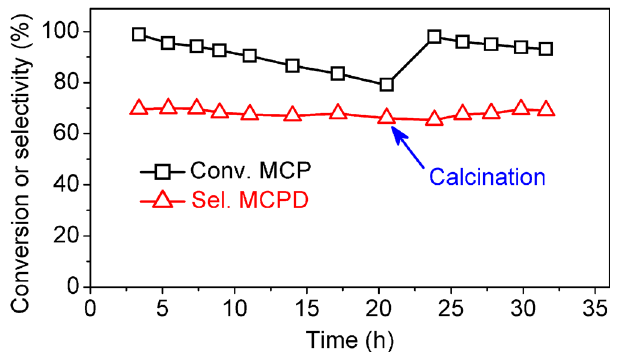
Fig. 4 The catalytic stability of 15wt.%MoO 3 /ZnO catalyst. Conditions: T = 400 °C, PH = 0.1 MPa, WHSV = 0.23 g g − 1 h − 1 , initial H 2 ratio is 40. MCP 3-methylcyclopent-2-enone, MCPD